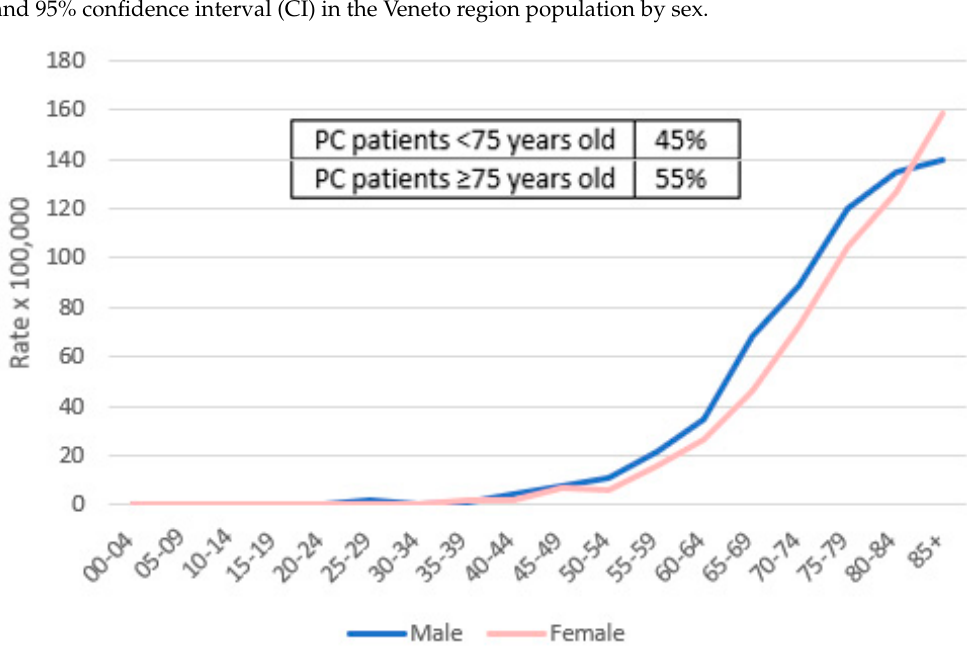
Figure 2. Incidence rate of pancreatic cancer in the Veneto region population by age and sex in 2018.